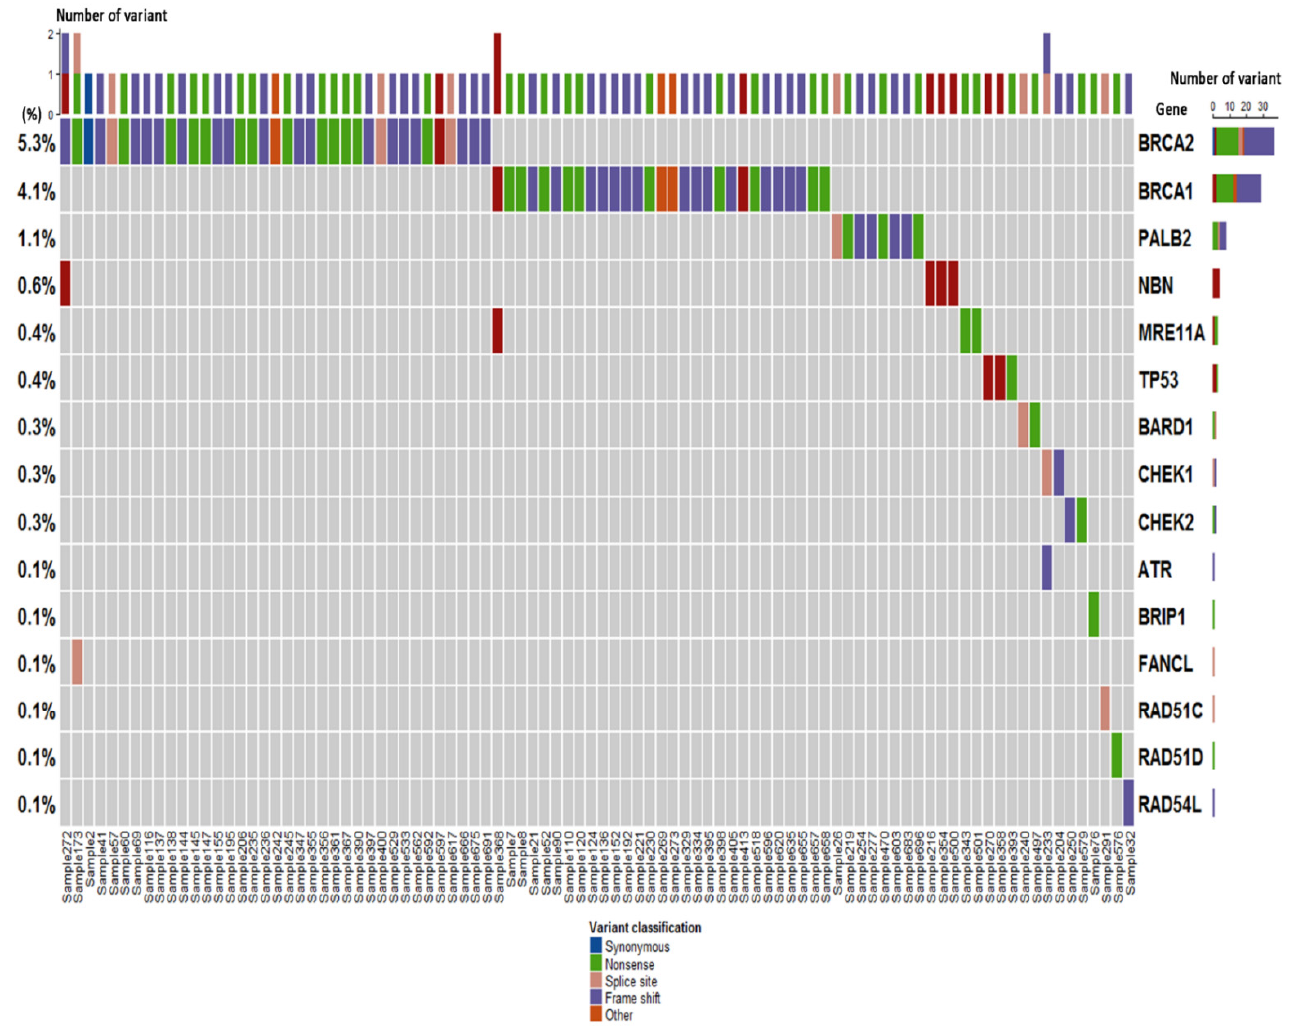
Figure 1. The spectrum of deleterious germline variants in 32 cancer-related genes among 700 Chinese breast cancer patients.